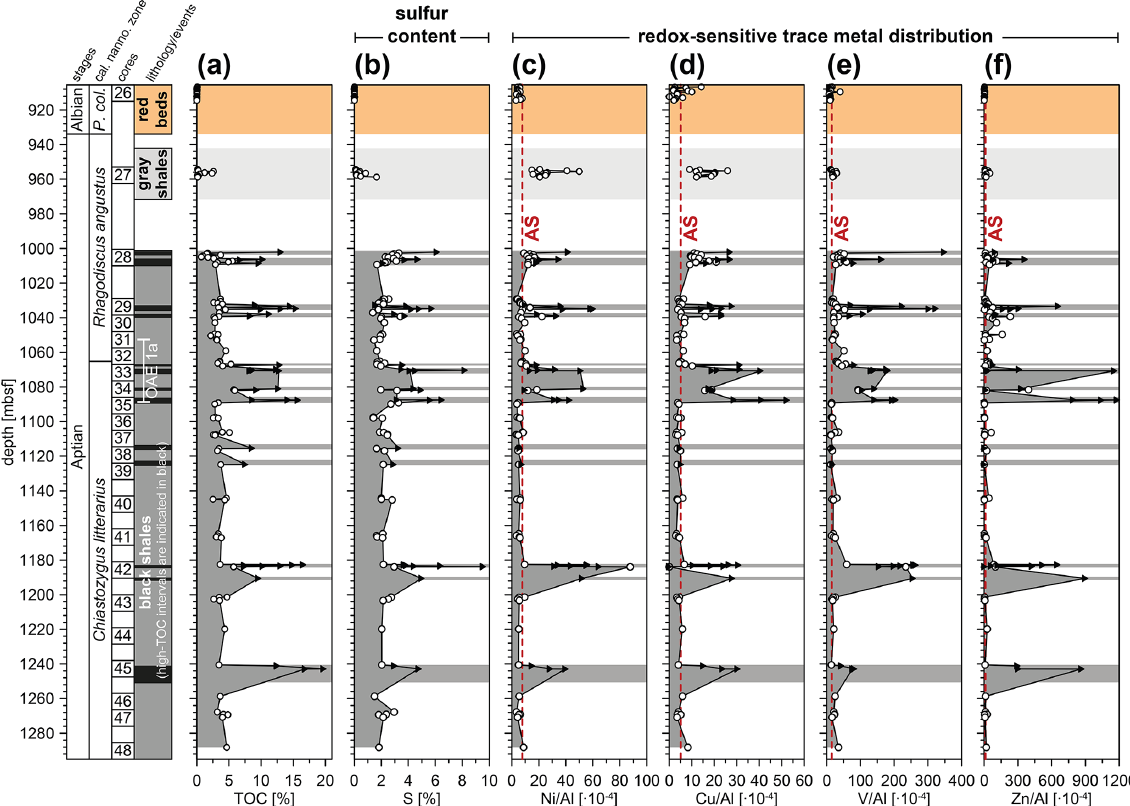
Figure 5. Inorganic geochemical parameters used to reconstruct paleo-redox conditions: (a) total organic carbon content (Dummann et al., 2020); (b) total sulfur content; and (c–f) Ni / Al, Cu / Al, V / Al, and Zn / Al ratios. Black triangles with background shading indicate high-TOC black shales ( > 6% TOC). Average shale TM / Al ratios (AS) are plotted as red dashed lines. P. col. is short for Prediscosphaera columnata